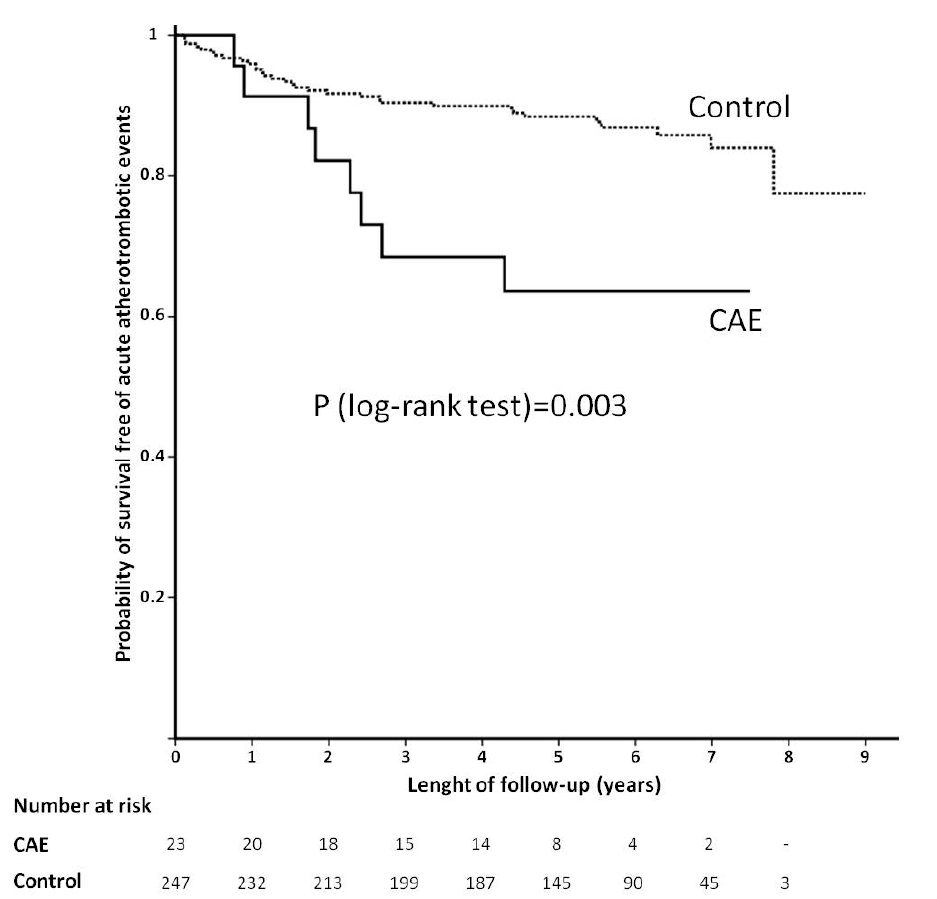
Figure 1. Comparison of long-term incidence of acute atherotrombotic events between patients with and without coronary artery ectasia (CAE). Survival curves are drawn with Kaplan–Meier method. Table 3. Cox regression analysis for predictors of acute atherothrombotic events during follow-up.